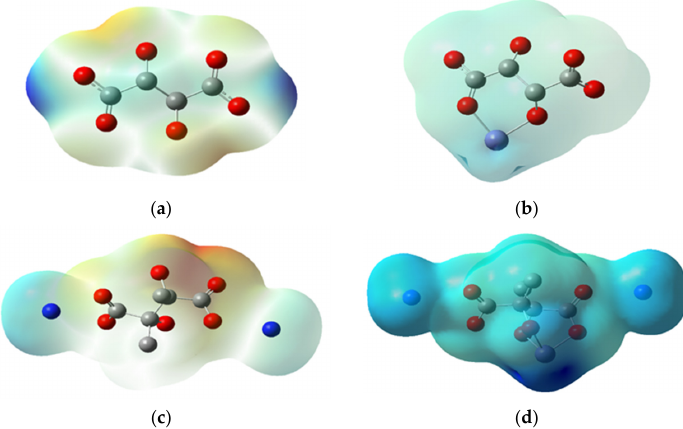
Figure 9. Electrostatic potential for 1n of ( a ) H-H (0.0737 eV), ( b ) Fe-H-H (0.9110 eV), ( c ) CH 3 -NH 4 (0.1190 eV) and ( d ) Fe-CH 3 -NH 4 (0.4240 eV). Table 4. The Mulliken charges of the oxygen atoms coordinated with Fe.